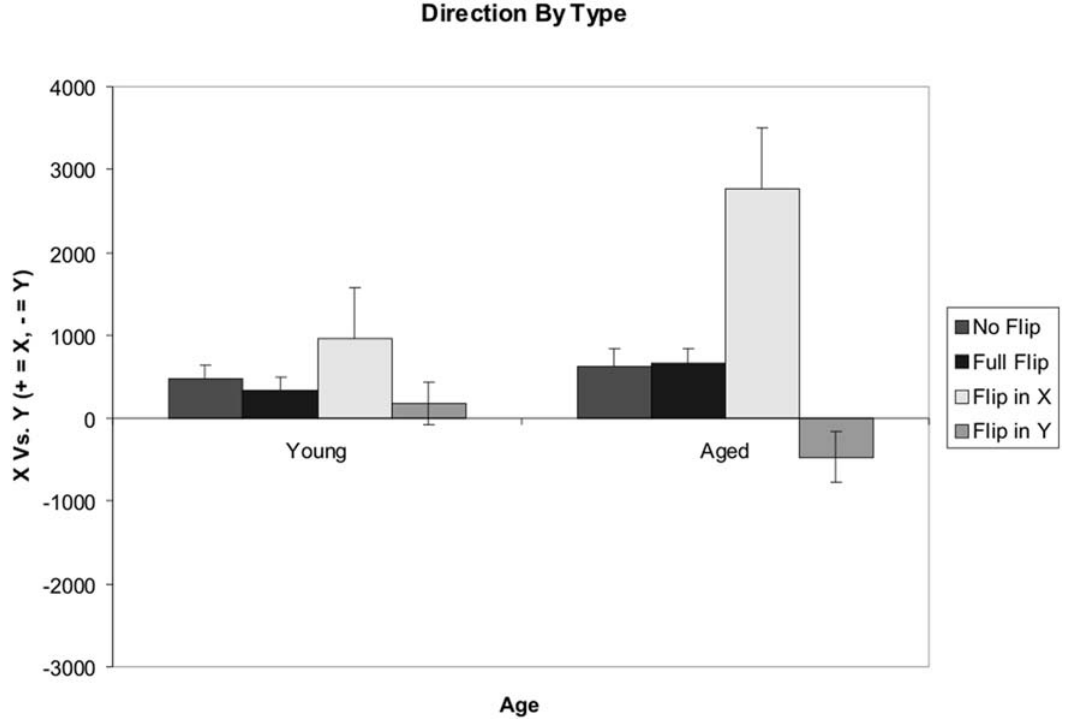
Figure 7. Direction of Movement (Summed X-Axis Movement – Summed Y-Axis Movement). Though not statistically significant, during an X-Axis or Y-Axis flip, the aged participants displayed more corresponding axis movement than did the younger controls. Error bars represent the standard error of the mean.